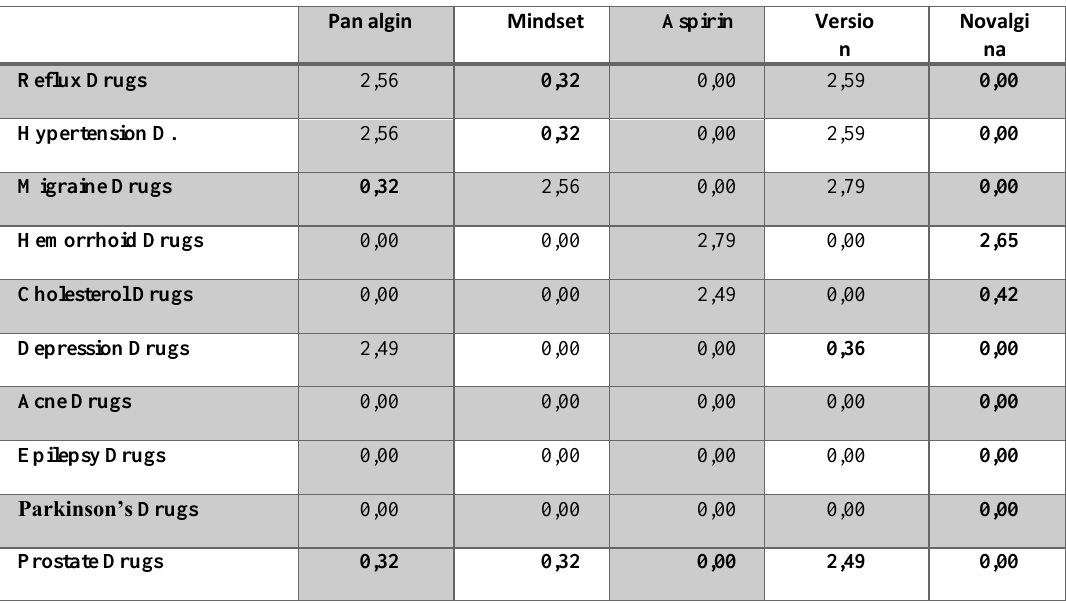
Table 6 . The estimated values for Painkiller Drugs Concerning Adamic Adar